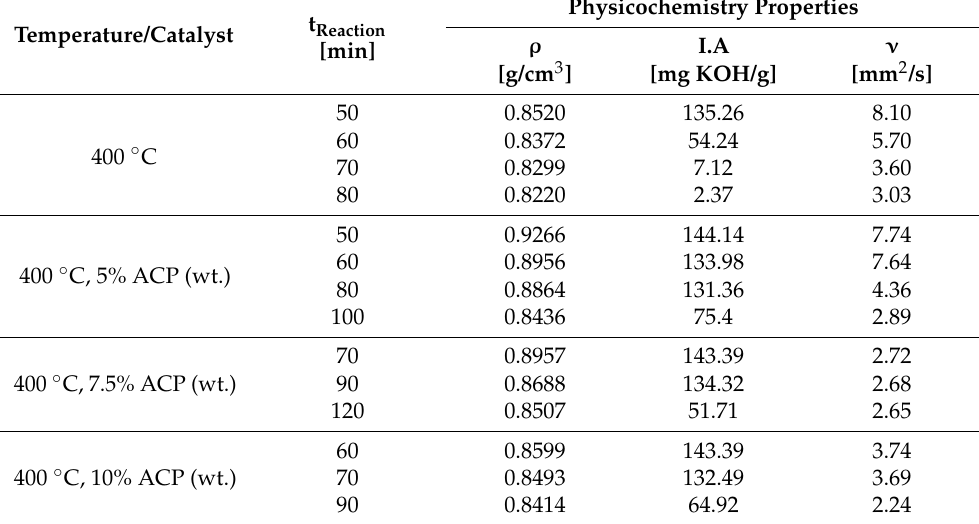
Table 4. Effect of reaction time on the density, kinematic viscosity, and acidity of bio-oil by catalytic upgrading of residual fat pyrolysis vapors at 400 °C, 1.0 atm, 0.0%, 5.0%, 7.5%, and 10.0% (wt.) activated carbon pellets impregnated with 10.0 M NaOH, using a catalyst fixed-bed reactor, in a semi-pilot scale two-stage reactor of 2.0 L.